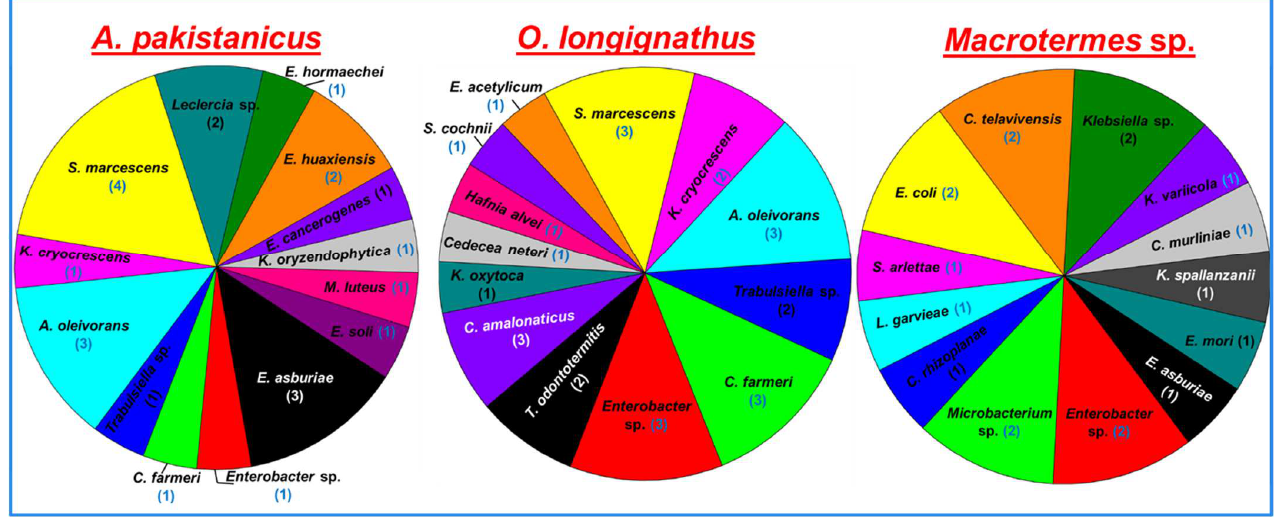
Figure 4. Species-wise diversity and richness of Avicel- and xylan-hydrolyzing bacteria isolated from different fungus-growing termites. The numbers given in brackets after bacteria indicate the number of isolates of a particular species.